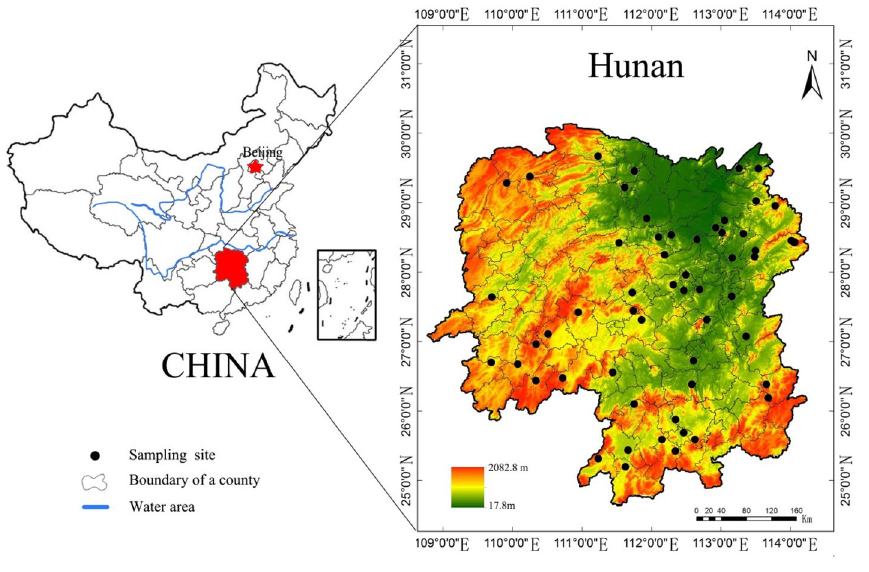
Figure 1. Study area and sampling